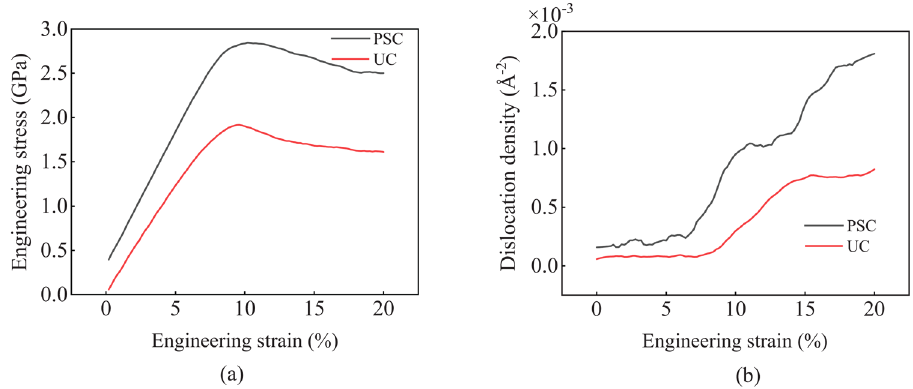
Figure 4: Parameter changes during compression: ( a ) stress – strain curve and ( b ) dislocation density